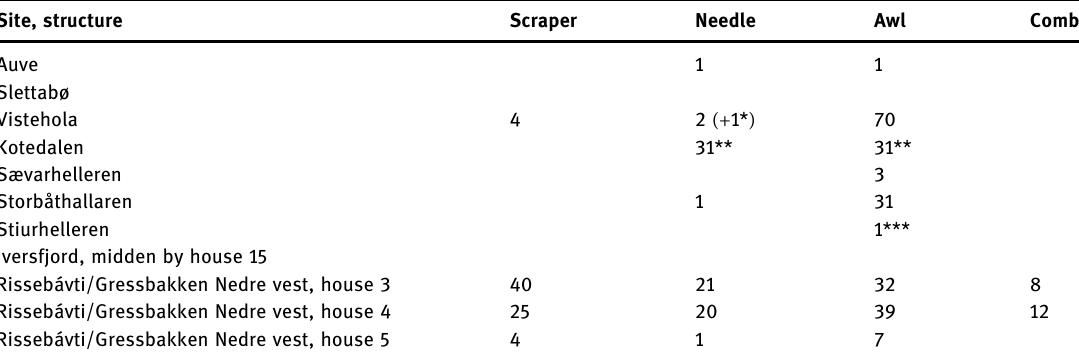
Table 4: Bone and antler tools used or possibly used in hide work from the case study sites Site, structure Scraper Needle Awl